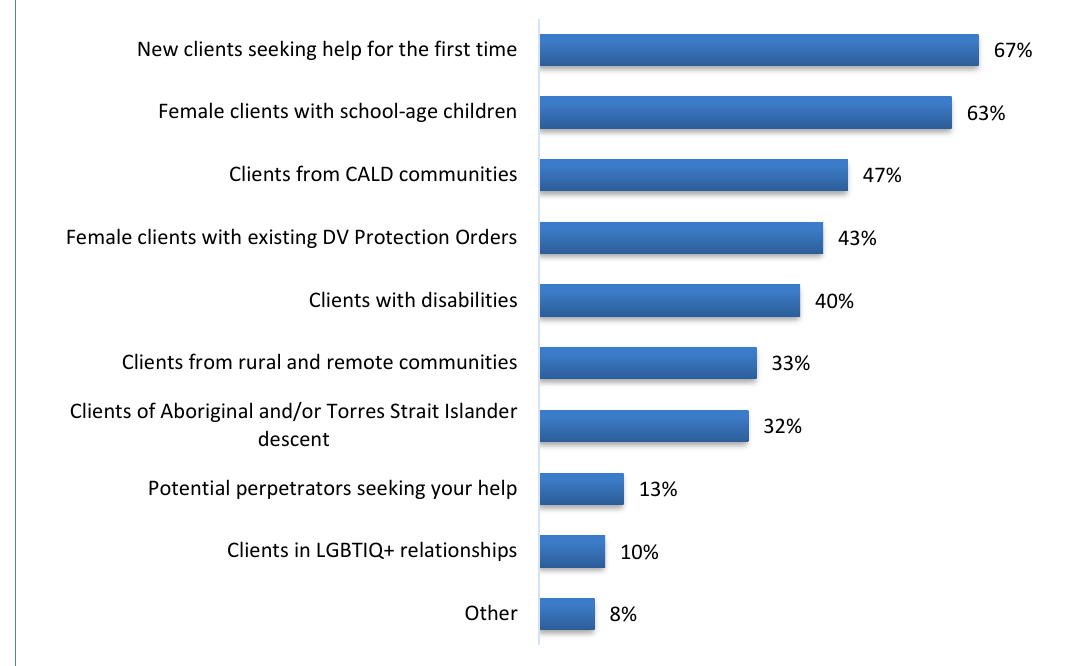
Figure 1. Has the COVID-19 pandemic had any particular effect on any of the above clients?